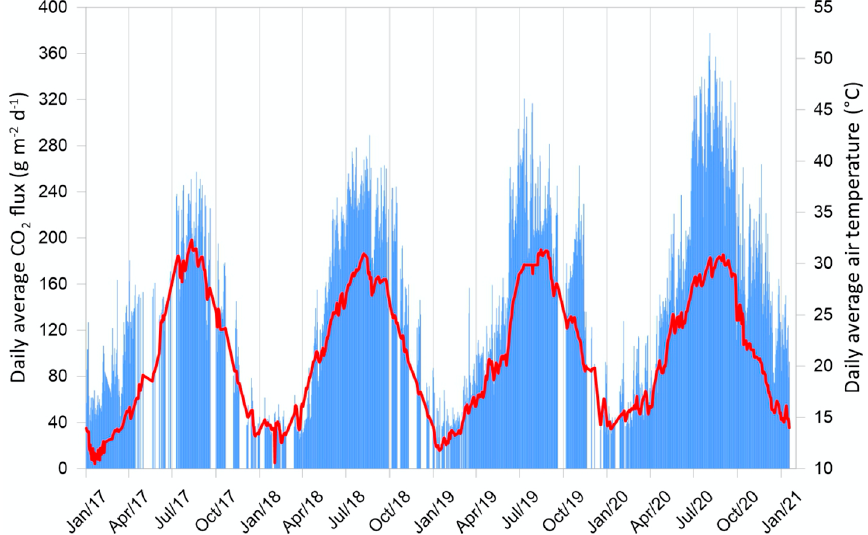
Figure 3. Daily average STR01 CO 2 flux (blue column) vs. time (2017–2021), and STR01 daily average air temperature (red line). The cyclic behavior of CO 2 fluxes and air temperature is very clear, with maximum and minimum values recorded for both parameters during the hot and cold season, respectively.